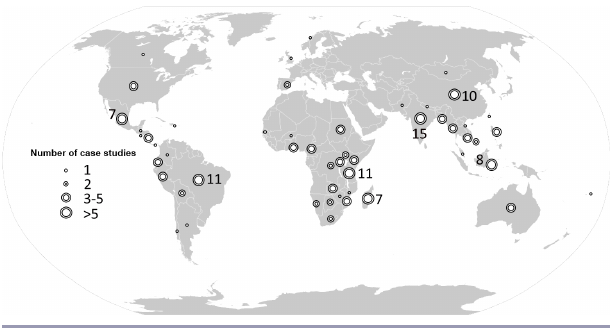
Fig. 3 . Geographic distribution of the 169 cases. For countries with more than five cases, the numbers are presented in the map.